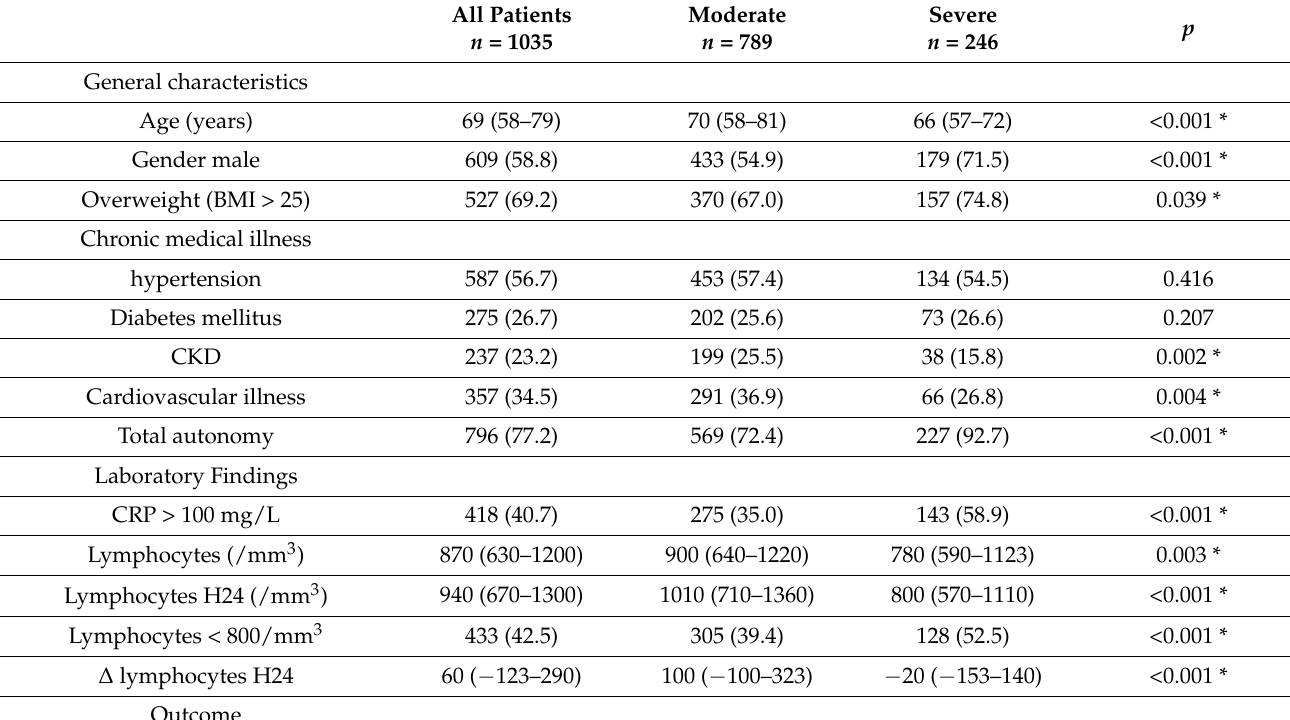
Table 1. Demographic, baseline, and laboratory characteristics of patients with